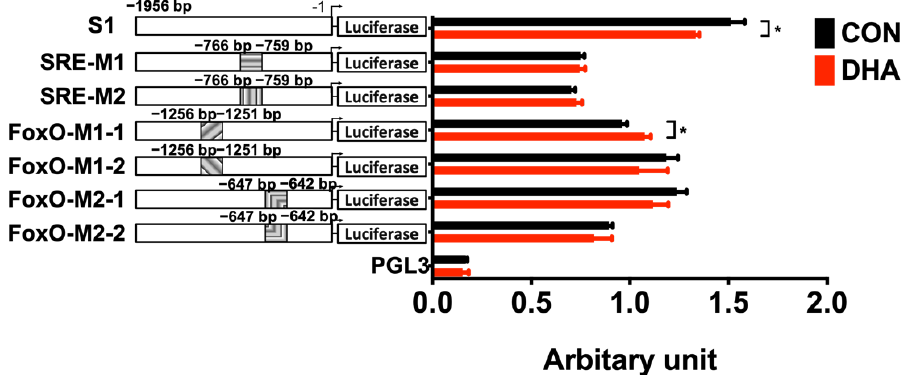
Figure 8. Identification of DHA-modulated response elements on TN promoter in HEK293T cells. Wild type (S1) or mutated promoter activities for gene tetranectin (TN/ CLEC3B ) were determined in HEK293T cells treated with 100 μM of DHA for 24 h by co-transfecting firefly and Renilla lucifer- ase vectors. The TN promoter had one predicted mutation site for sterol regulatory element (SRE) and two mutation sites for forkhead response elements (FHRE). Seven clones were generated and cloned into each firefly luciferase vector including one 1956-bp of wild-type TN promoter (S1), two different clones (M1 and M2) within the same mutated location of SRE, and two clones of mutated FHRE at two dispersed locations (M1-1, M1-2, M2-1, and M2-2). The values of relative light units (RLU) were normalized to correct for transfection efficiency using the Renilla luciferase activity. Data were expressed as means ± SD ( n = 3) with arbitrary units and analyzed by Student’s t -test. Asterisks indicate statistical significances, p ≤ 0.05. SRE-M1: clone 1 of TN promoter with mutated SRE (−759 to −766); SRE-M2: clone 2 of TN promoter with mutated SRE (−759 to −766); FoxO-M1-1: clone 1 of TN promoter with mutated FHRE at first mutation site (−1251 bp to −1256); FoxO-M1-2: clone 2 of TN promoter with mutated FHRE at first mutation site (−1251 bp to −1256); FoxO-M2-1: clone 1 of TN promoter with mutated FHRE at second mutation site (−642 bp to −647); FoxO-M2-2: clone 2 of TN promoter with mutated FHRE at second mutation site (−642 bp to −647).